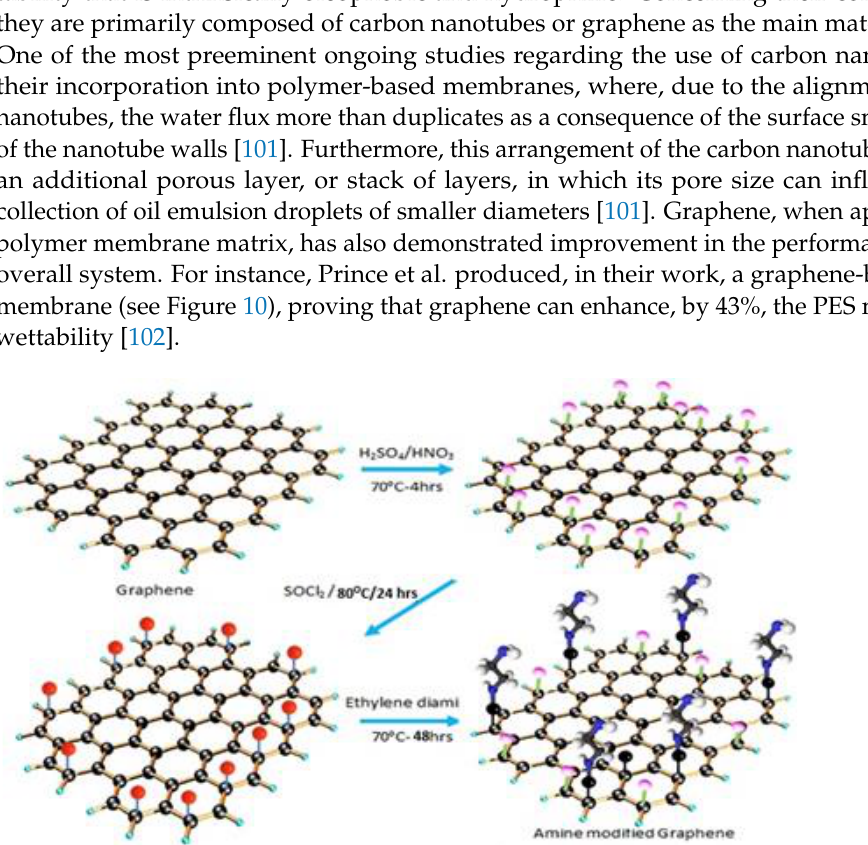
Table 1. Oil removal efficiency for oil/water mixture separation. Efficiency for Oil/Water Mixture Separation Foams and sponges Commercial copper foam surface modified with polydopamine, AgNO 3 , n-dodecyl mercaptan